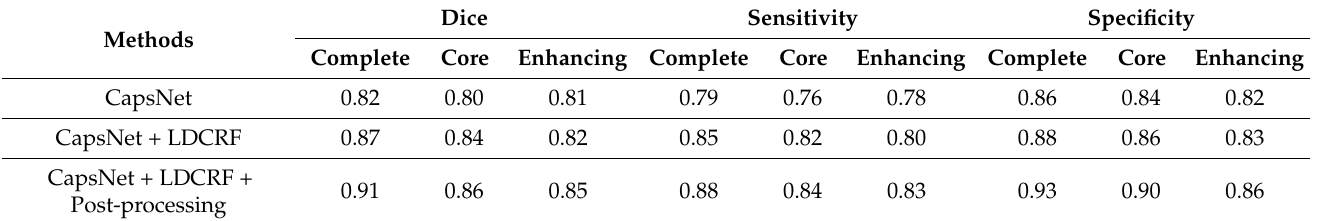
Figure 7. Results of the segmentation on MR images with respect to MICCAI BRATS 2015 dataset. Four input modalities are shown in the top row from left to right (T1, T1c, Flair, T2). Ground truth (GT) as well as segmentation outcomes utilizing CapsNet, CapsNet + LDCRF, and CapsNet + LDCRF + post-processing, respectively, in the bottom row (left to right) with red label 1 (necrosis), green label 2 (edema), blue label 3 (non-enhancing), and yellow label 4 (enhancing). Table 3. On the MICCAI BRATS 2015 dataset, segmentation outcomes with respect to the Dice score, sensitivity, and specificity.